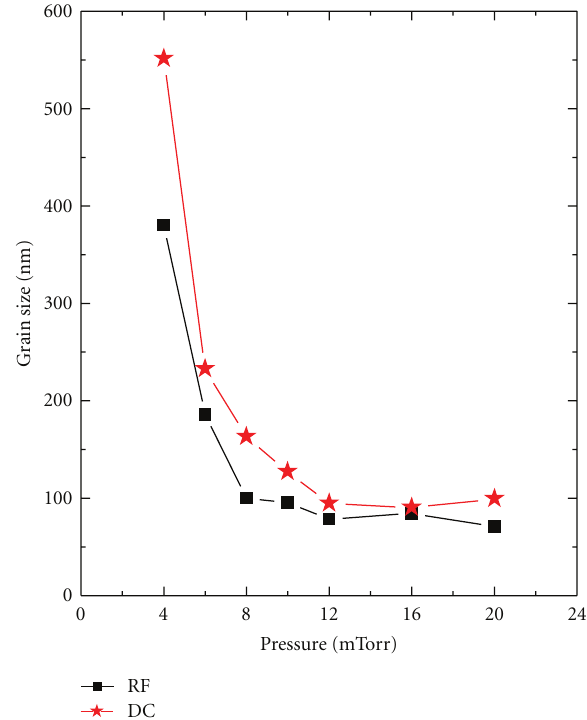
Figure 4: Variation of average grain size of rf and dc films as a function of pressure. The lines connect data points as guides to the